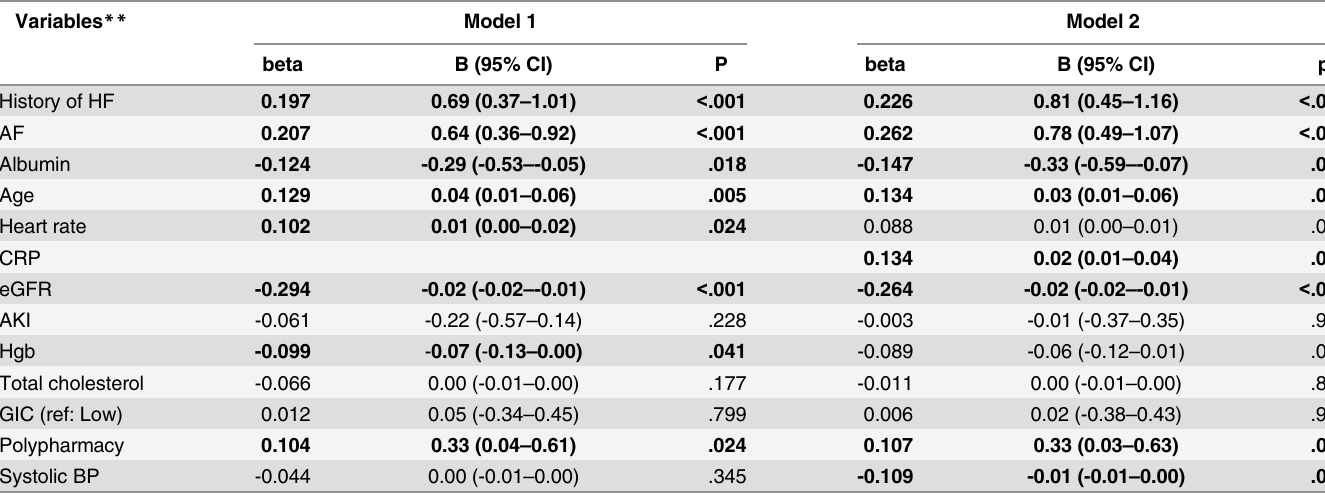
Table 3. Multiple Linear Regression for ln(NT-proBNP).